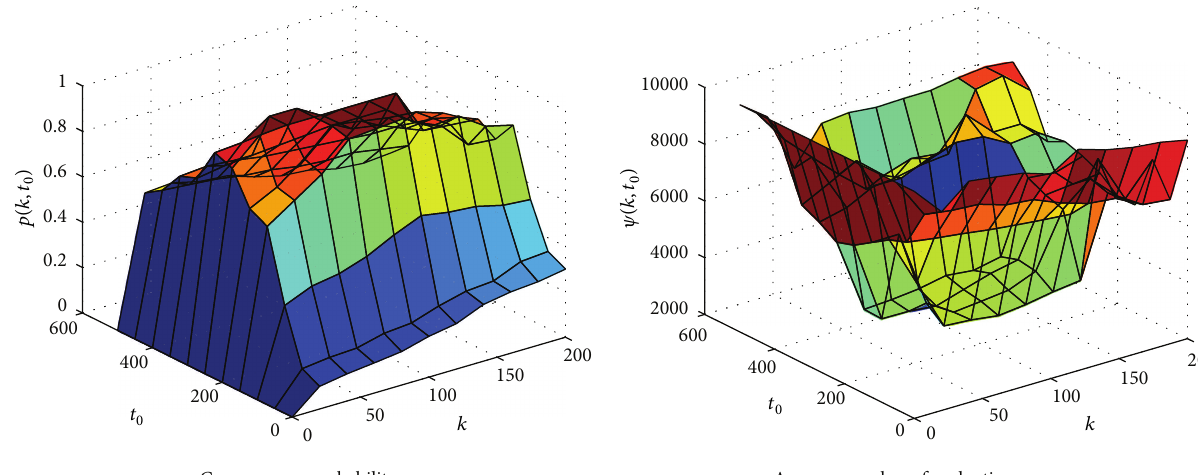
Figure 2: Charts of changes of parameter